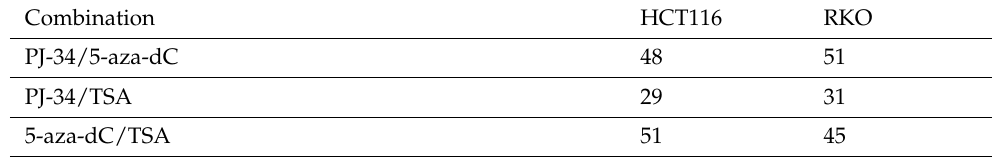
Table 2. Number of genes that were reactivated by the combinational treatment of chemicals, where flag shows present or